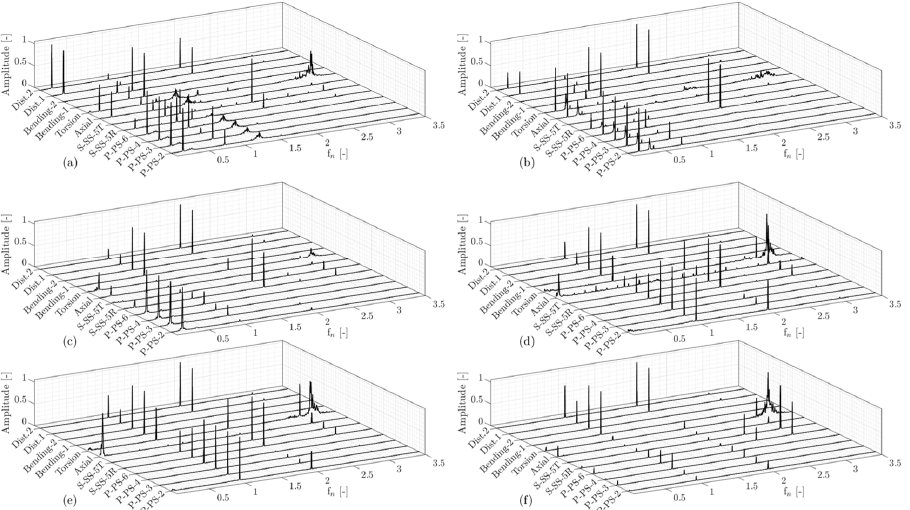
Figure 17 . Amplitude spectra of pressure, strain, and displacement data obtained on the runner blade and shaft at low-frequency region; ( a ) OP6, ( b ) OP7, ( c ) OP8, ( d ) OP9, ( e ) OP10, and ( f ) OP0. ‘Dist.1 ′ and ‘Dist.2 ′ denote the first and second proximity probes.